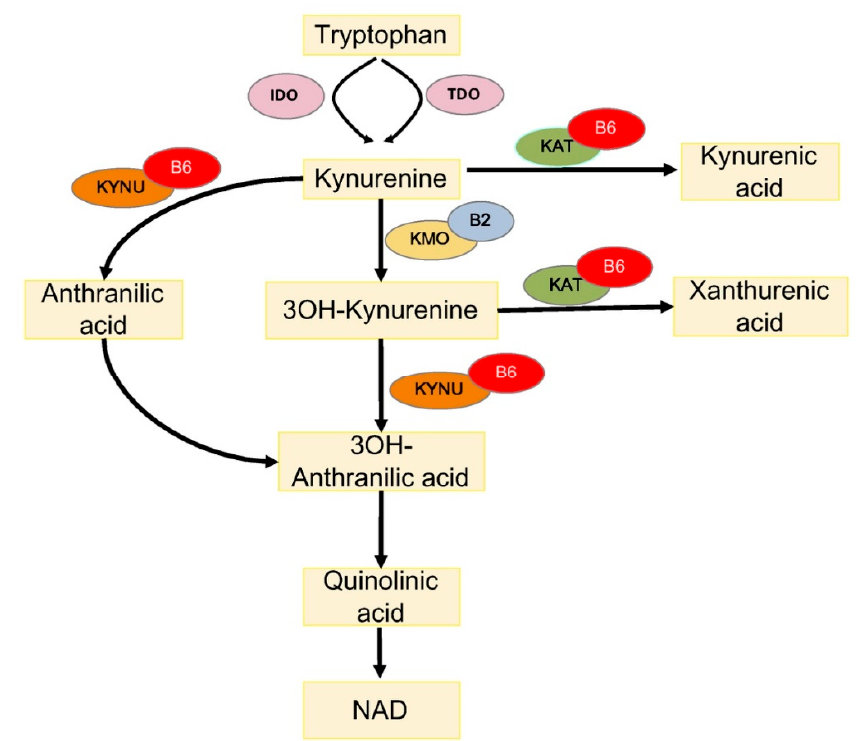
Figure 2. Tryptophan metabolism via the kynurenine pathway. IDO, indoleamine 2,3-dioxygenase; TDO, tryptophan 2,3-dioxygenase; KAT, kynurenine aminotransferase; KMO, kynurenine 3-monooxygenase; KYNU, kynureninase; 3OH-kynurenine, 3-hydroxy kynurenine; 3OH-anthranilic acid, 3-hydroxyanthranilic acid; B6, vitamin B6 (pyridoxal 5`-phosphate); and B2, vitamin B2 (flavin adenine dinucleotide).